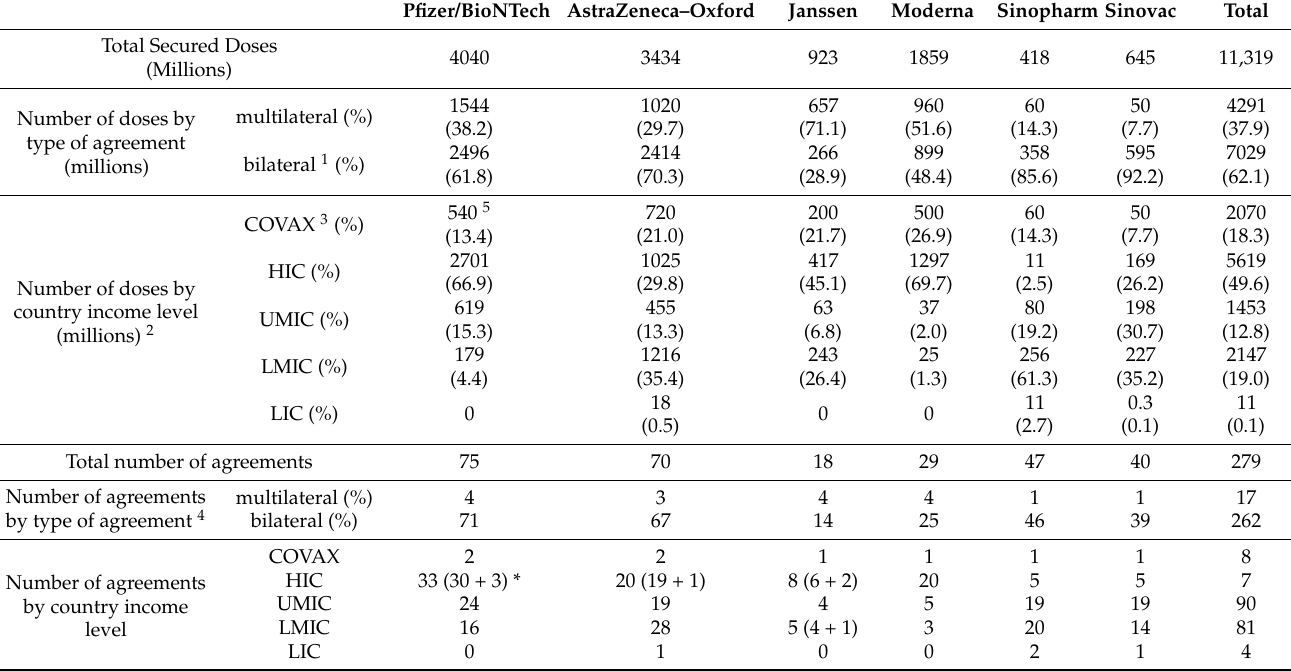
Table 4 analyzed how the procured vaccines were distribute using two categories: (i) type of agreement (multilateral, bilateral) and (ii) country income level. The type of agreement was classified as multilateral and bilateral. Multilateral deals include contracts with COVAX, the European Commission, and the African Union. Country income level was classified as HIC (high-income countries), UMIC (upper-middle-income countries), LMIC (lower middle-income countries), and LIC (low-income countries). The countries were clas- sified according to the World Bank country classifications by income level: 2020–2021 [62]. Data on the number of secured vaccine doses and contracts were obtained by the UNICEF COVID-19 Vaccine Market Dashboard until August 2021. Table 4. Vaccine supply agreements made by the vaccine developers, sorted by type of agreement and economy level. Pfizer/BioNTech